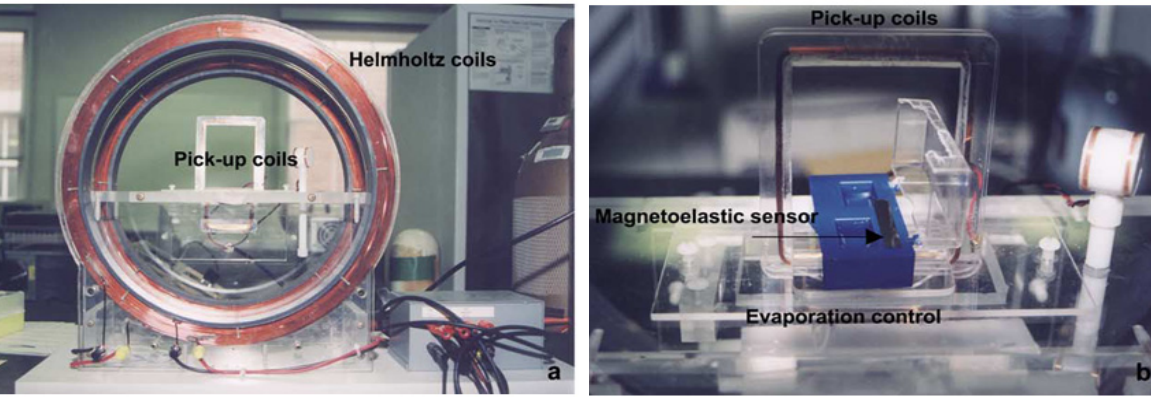
Figure 7. Magnetoelastic-sensing system coil design in its infancy. Shown is a side view of the Helmholtz coils used to generate the ac and dc fields, and an enlarged view of the rectangular pick-up coil with the sensor stage in the middle. Reprinted with permission from